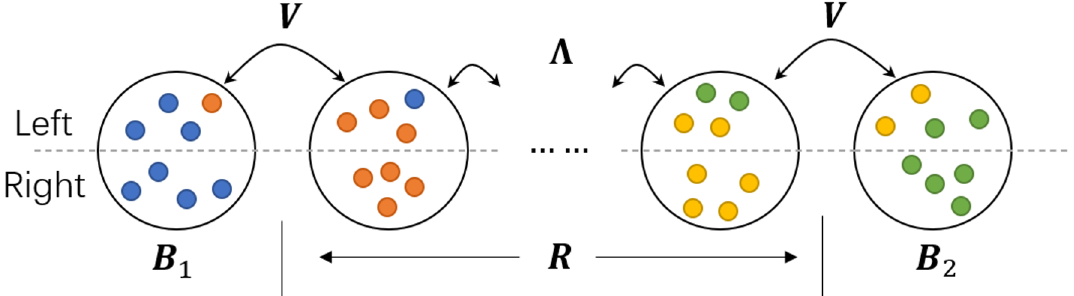
Figure 15 . A chain model consisting of EPR clusters at early times, where one right qubit has only been entangled with one left qubit in the same color. Without loss generality, we simply require the right qubits remain still, while only those on the left will